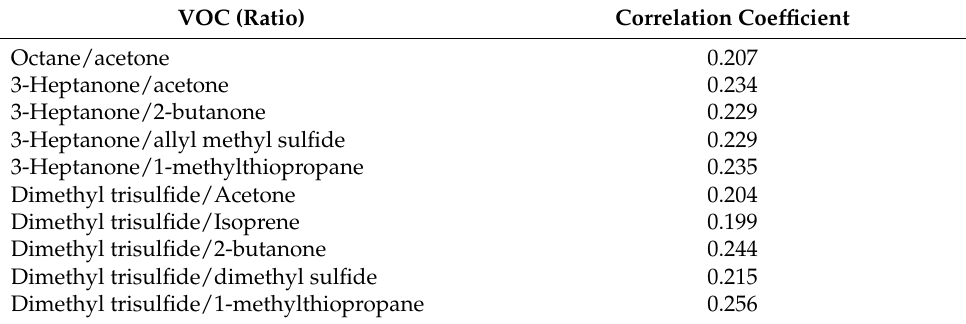
Table 5. Correlation coefficients between VOCs (their ratios) and histological